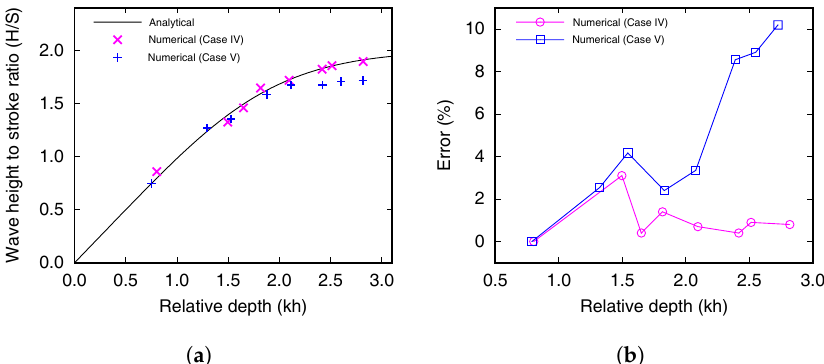
Figure 10. Curves showing a comparison of ( a ) the wave height to stroke ratio and ( b ) errors obtained using the plane wavemaker theory and via numerical